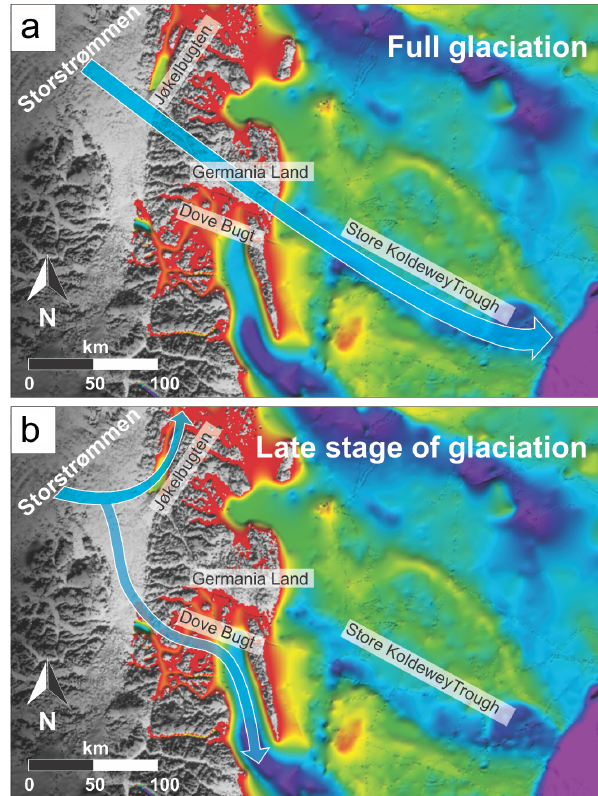
Figure 8. Reconstruction of inferred paleo-ice-flow directions showing (a) paleo-ice-flow unrelated to the underlying topogra- phy during full glaciation and (b) ice drainage paths during a late stage of glaciation (bathymetry and topography from IBCAO v.4.0; Jakobsson et al.,